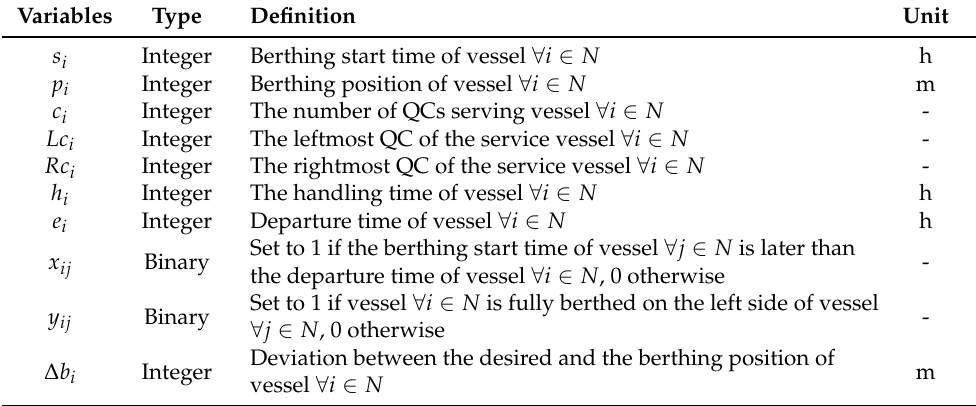
Table 1. Variables used in model. - is a dimensionless